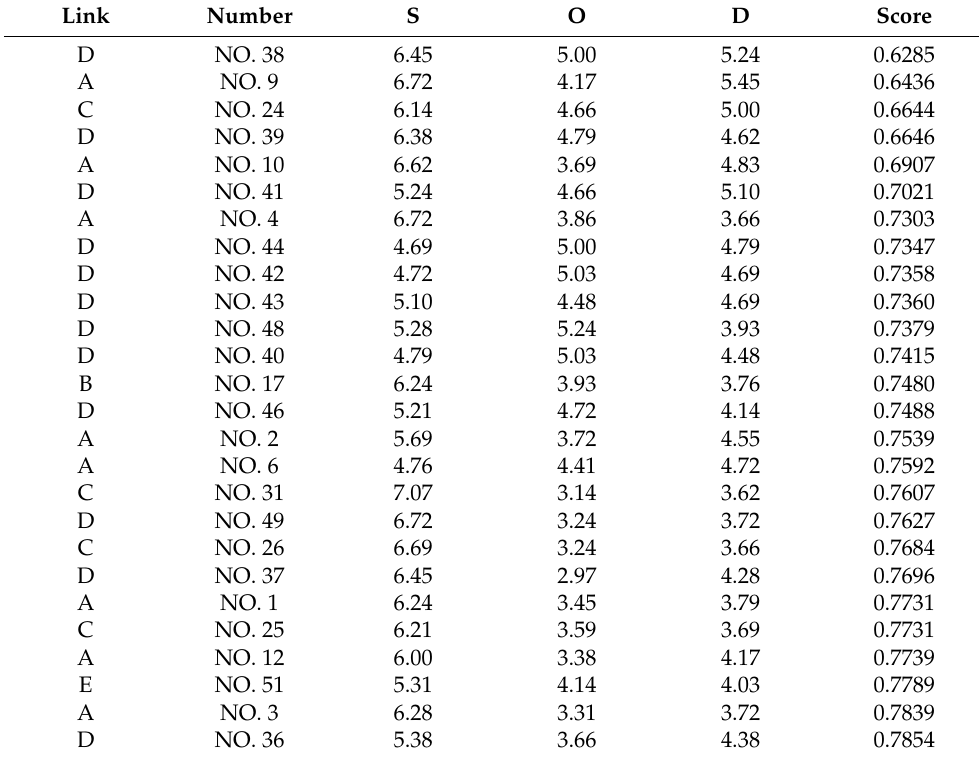
Table 3. Scores of S, O, and D dimensions of failure mode and efficiency score of SBM-DEA